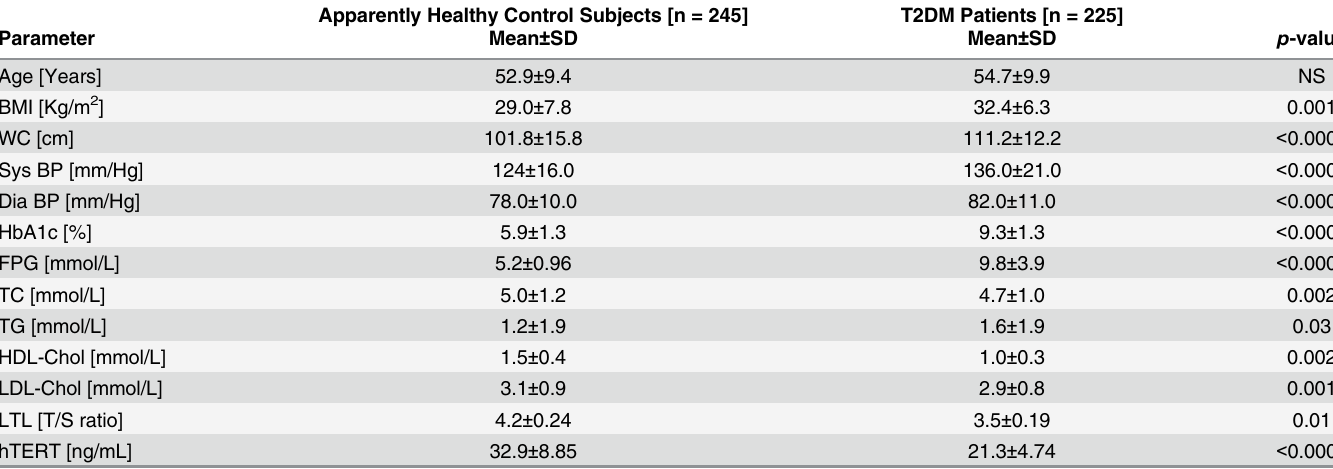
Table 1. Demographic, anthropometric and biochemical characteristics of the study